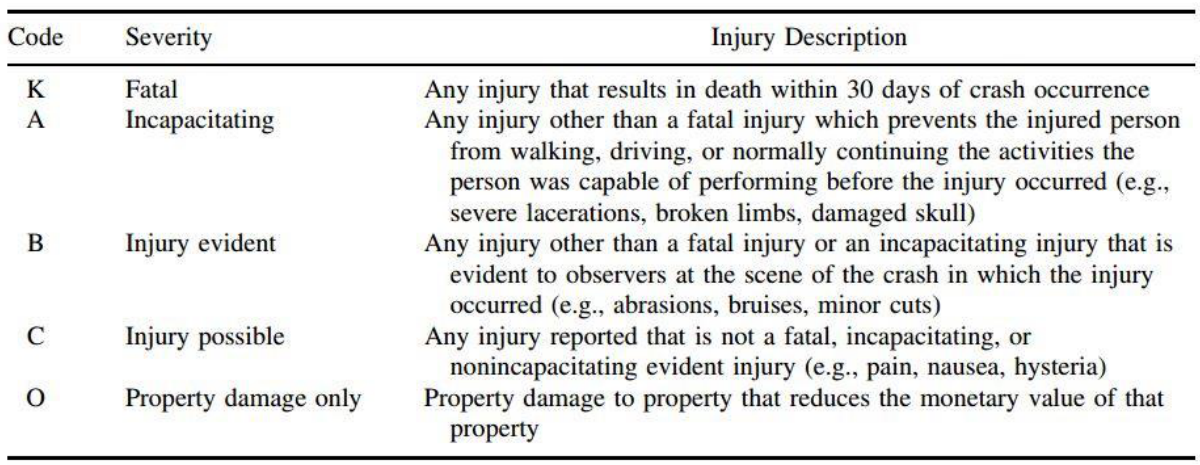
Table 1: KABCO Scale for Crash